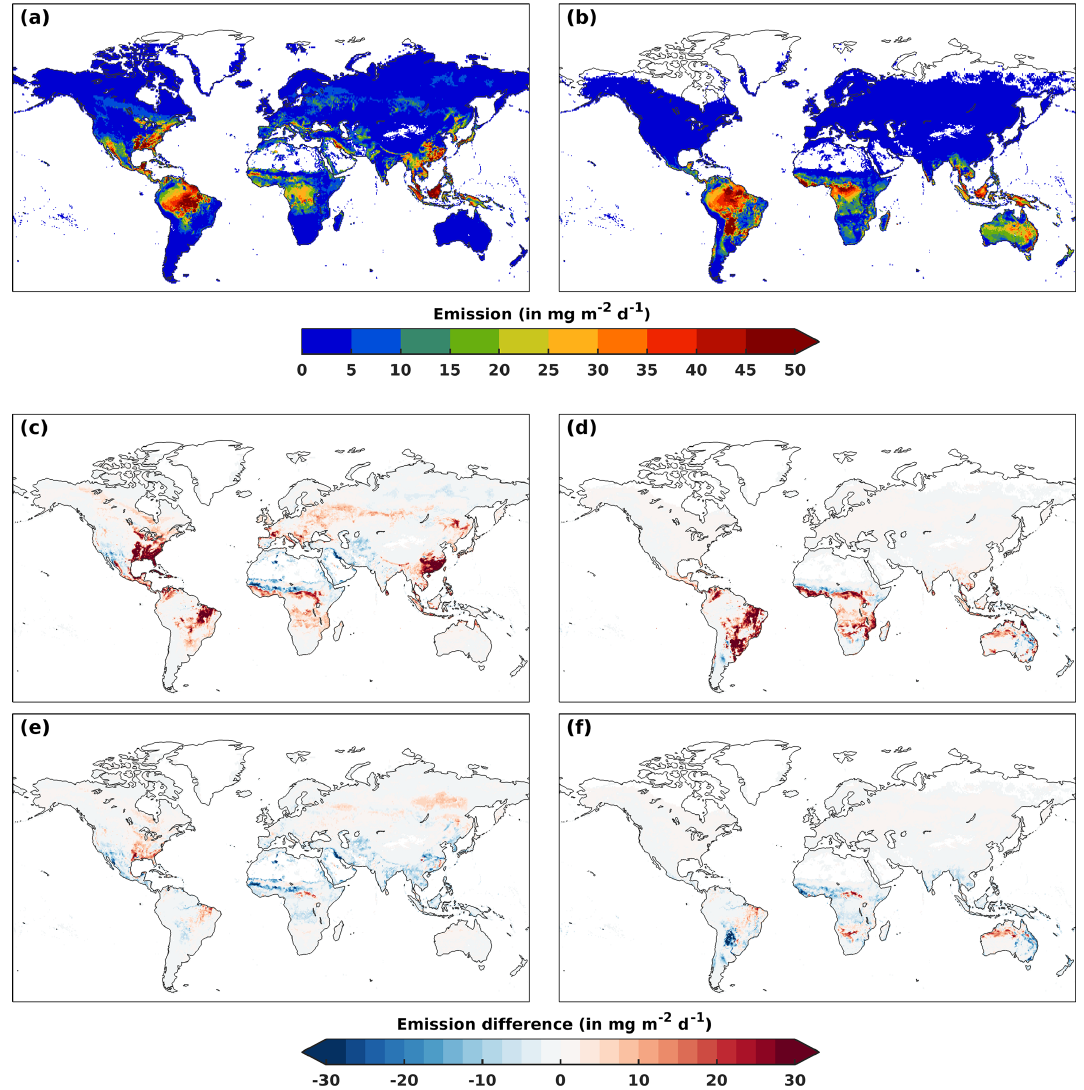
Figure 5. Distribution of isoprene emissions (in mgm − 2 d − 1 ) for (a) June–July–August (JJA) and (b) December–January–February (DJF) in 2001 in simulation CTRL, and emission differences of ISOPMOD-CTRL in (c) JJA and (d) DJF and of ISOPGFW-CTRL in (e) JJA and (f)